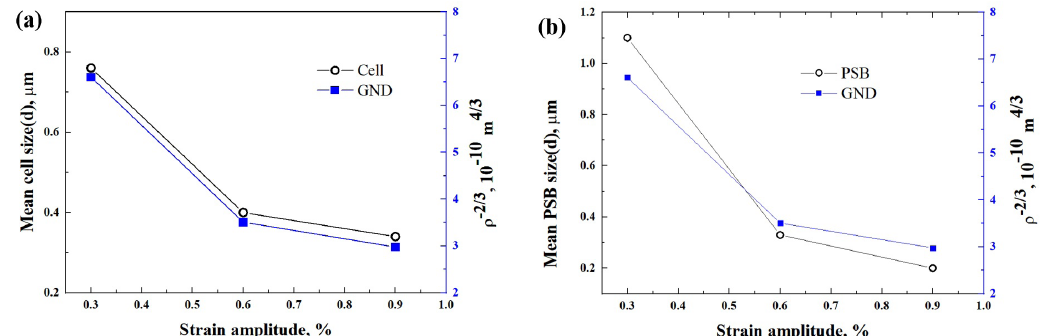
Figure 8. GND density dependence on the mean size of dislocation microstructures under the different strain amplitudes. (a) GND density and cells, (b) GND density and